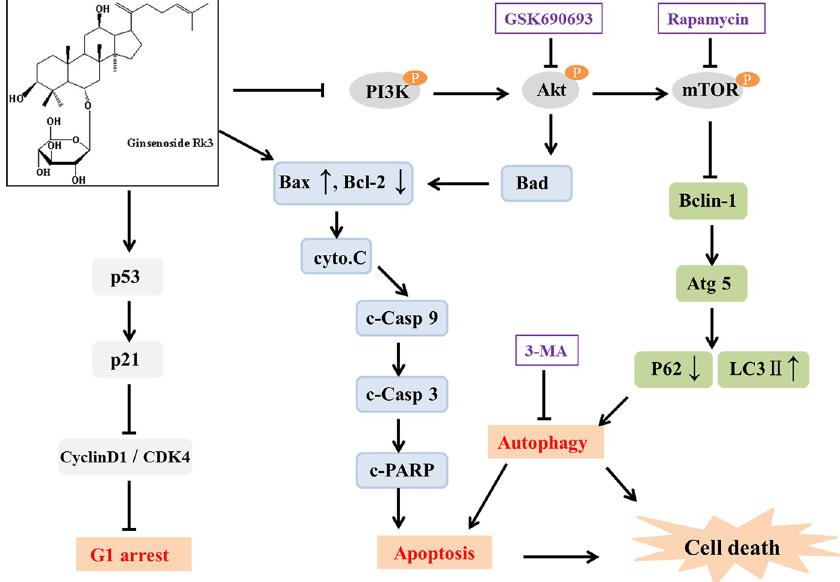
Fig 7. Proposed molecular mechanism of the anti-esophageal cancer activity of Rk3. The PI3K/Akt/mTOR signaling pathway is involved in apoptosis and autophagy induced by Rk3 in esophageal cancer.